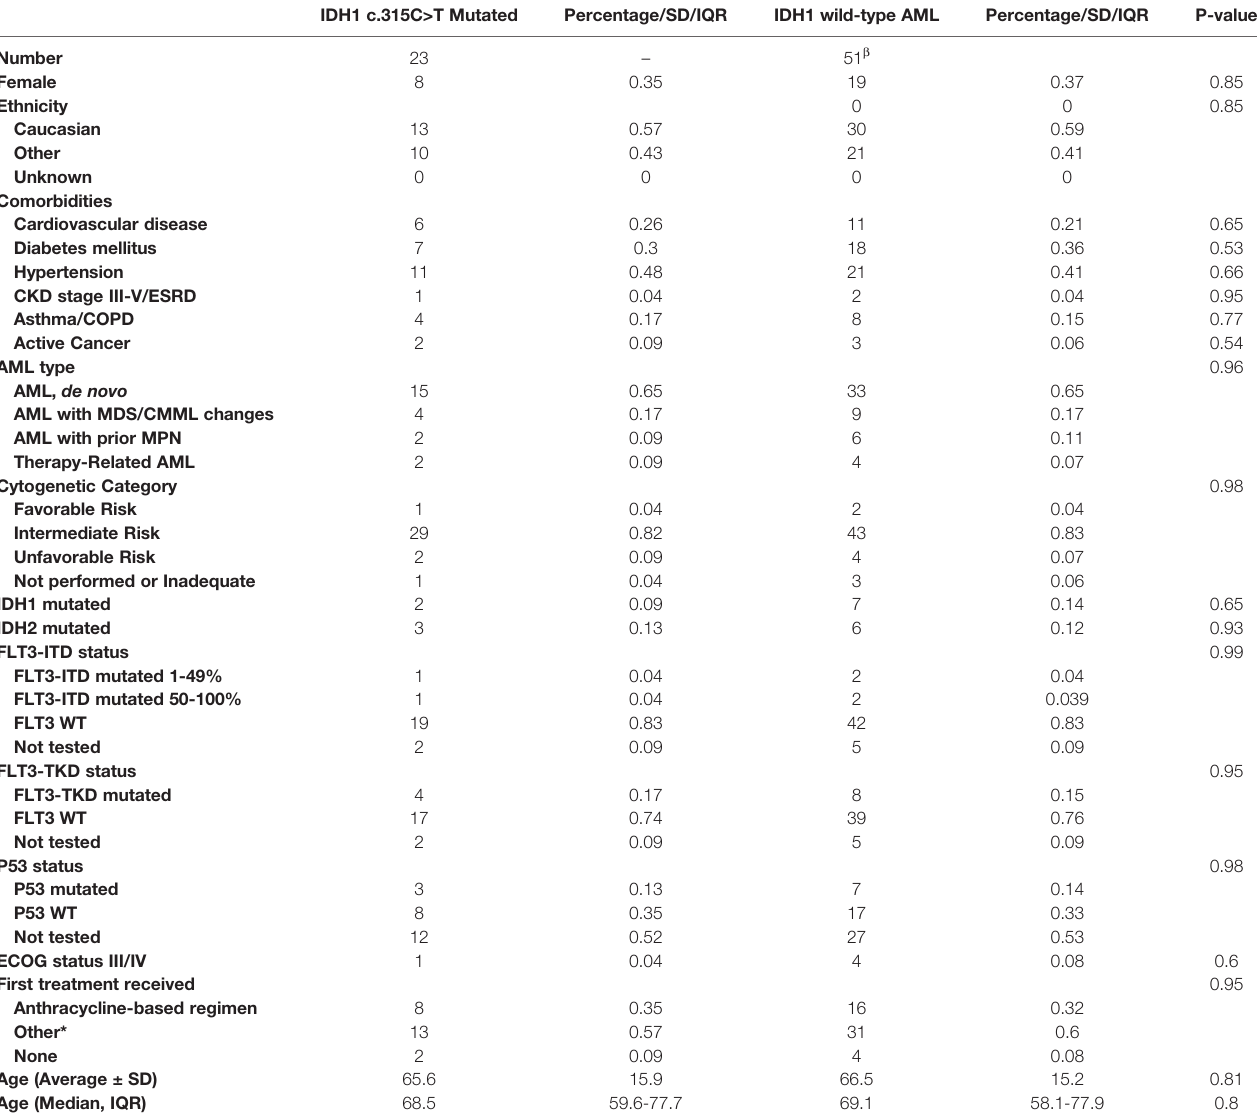
TABLE 1 | Adjusted baseline characteristics of patients with IDH1 c.315C>T mutated vs. IDH1 wild-type AML. IDH1 c.315C>T